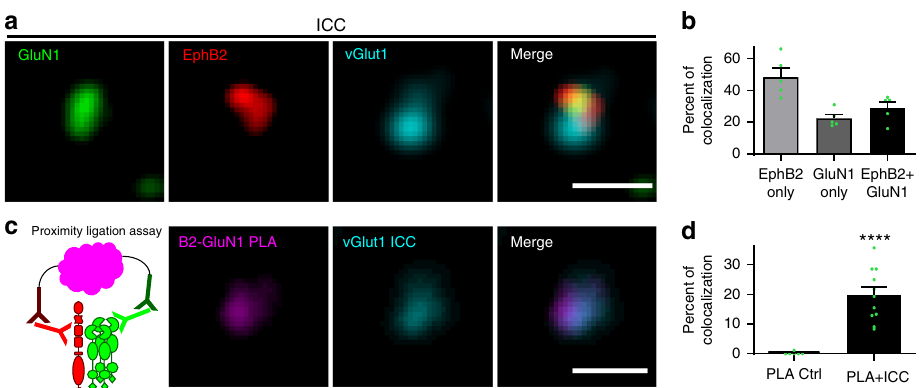
Fig. 1 GluN1 interacts with EphB2 at synapses. a Representative images of synaptosomes immunostained for GluN1 in green, EphB2 in red, and vGlut1 in cyan. Far right panel shows merged image. Scale bar = 1.5 µ m. b Quanti fi cation of the percentage of vGlut1 + synaptosomes that colocalize with either EphB2 only, GluN1 only, or both EphB2 and GluN1 (green dots represent n = 612 synaptosomes, fi ve fi elds). c Schematic of proximity ligation assay shows EphB2 in red and NMDAR in green. Rolling circle ampli fi cation of fl uorescently tagged oligonucleotides (represented in magenta) occurs after primary and secondary probes bind. Representative images of synaptosomes immunostained for vGlut1 in cyan (middle panel). PLA between EphB2 and GluN1 is shown in magenta (left panel). Right panel shows merged image. Scale bar = 1.5 µ m. d Quanti fi cation of the percentage of vGlut1 + synaptosomes that colocalize with PLA puncta (PLA + ICC). The control condition (PLA Ctrl) was performed without EphB2 primary antibody (**** p < 0.0001, unpaired t -test; green dots represent PLA Ctrl n = 569, 6 fi elds; PLA + ICC n = 421 synaptosomes, 11 fi